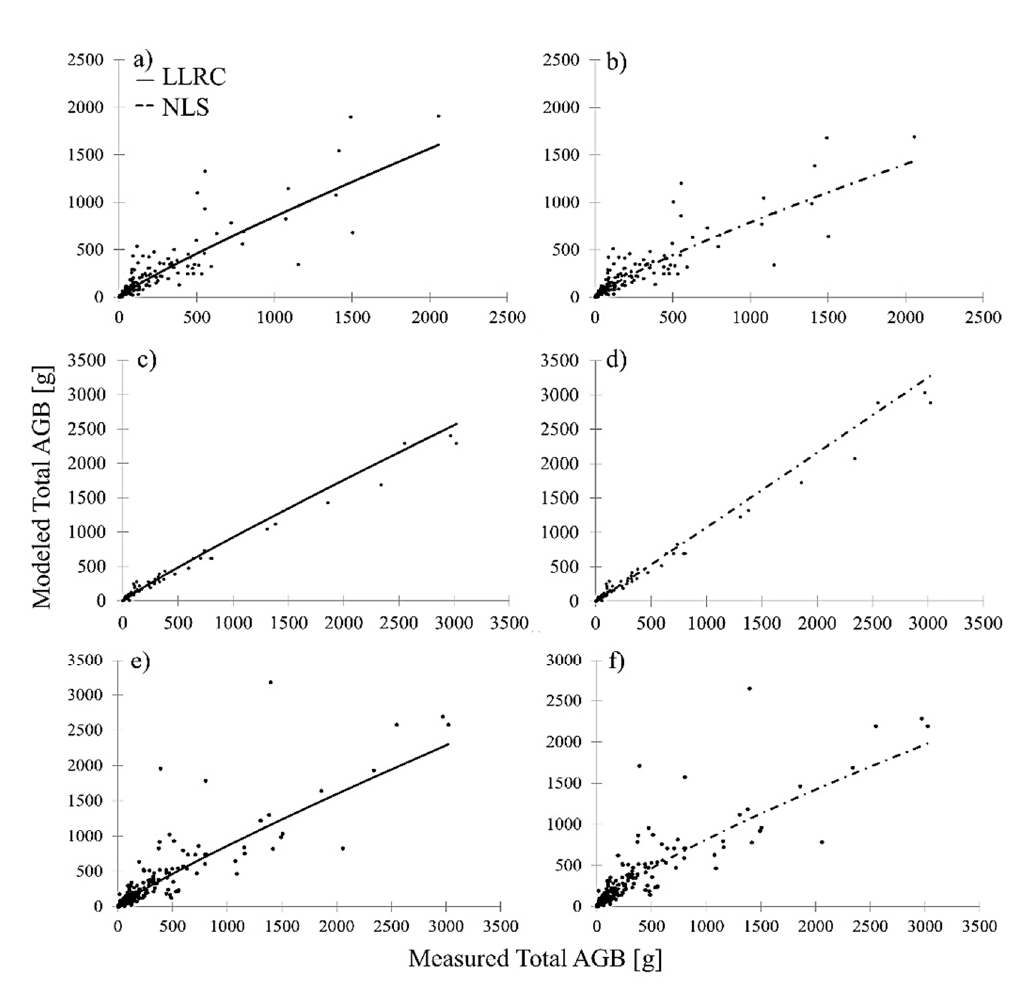
Figure 6. Measured total AGB related to modeled total AGB using LLRC and NLS for the 3D-based equations for multispecies shrubs ( a , b ) and the 2D-based equations for multispecies trees ( c , d ) as well as general shrubs and trees ( e , f